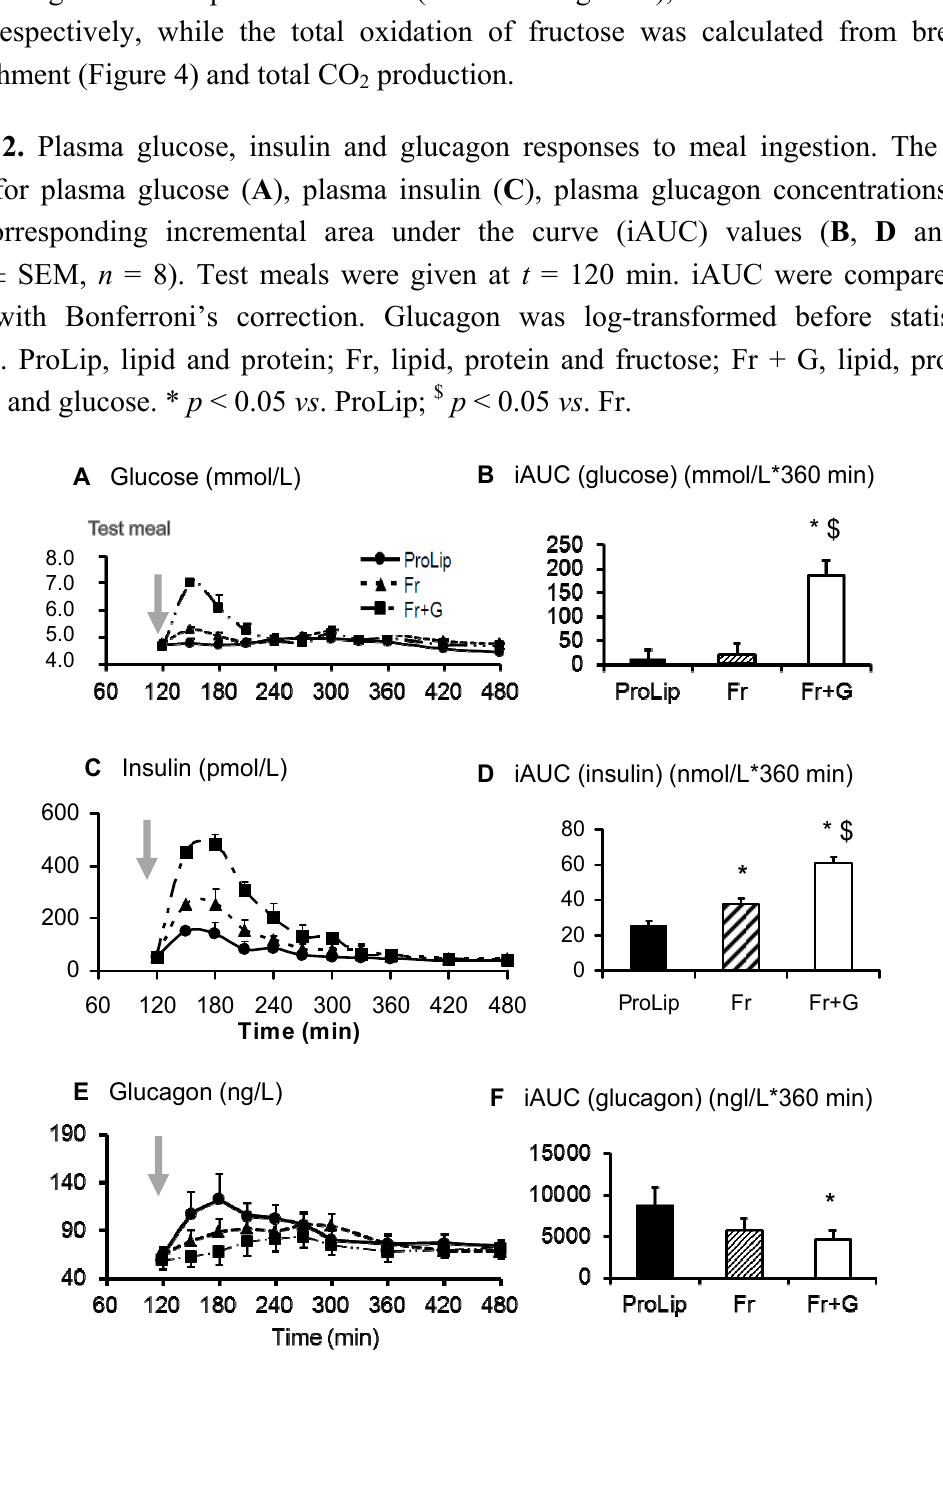
Figure 2. Plasma glucose, insulin and glucagon responses to meal ingestion. The time course for plasma glucose ( A ), plasma insulin ( C ), plasma glucagon concentrations and their corresponding incremental area under the curve (iAUC) values ( B , D and F ) (mean ± SEM, n = 8). Test meals were given at t = 120 min. iAUC were compared by t -tests with Bonferroni’s correction. Glucagon was log-transformed before statistical analysis. ProLip, lipid and protein; Fr, lipid, protein and fructose; Fr + G, lipid, protein, fructose and glucose. * p < 0.05 vs . ProLip; $ p < 0.05 vs . Fr.